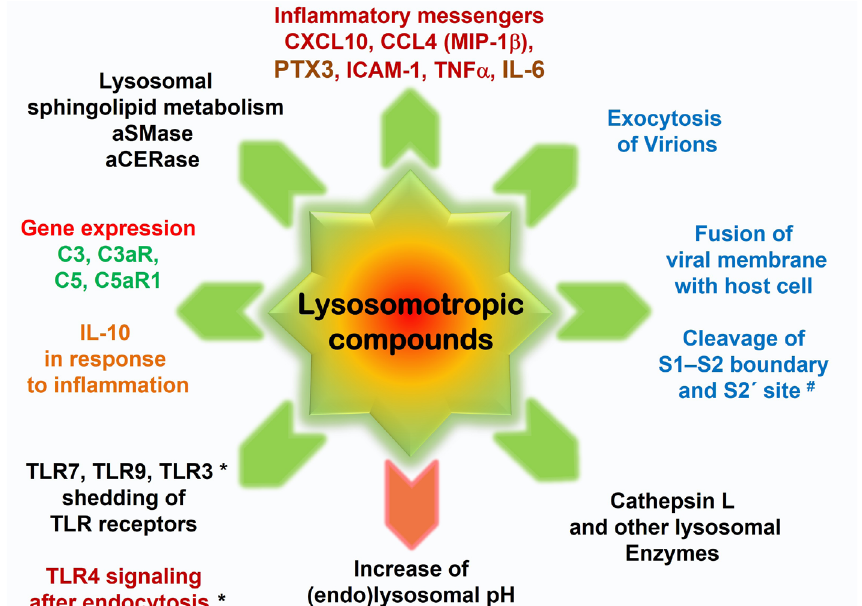
Figure 1. Targets of lysosomotropic drugs and metabolites in sepsis, SARS-CoV-2 infection, and severe SARS-CoV-2 infection/ COVID-19. Lysosomotropic compounds aim various targets in host cells: lysosomal pH, enzymes, and metabolism (black); in response to LPS-induced inflammation/severe viral infection (dark red); in SARS-CoV-2 infection of host cells and viral replication (blue); and the expression of C3, C3aR, C5, and in particular of C5aR1, a highly probable promoter of sepsis and COVID-19 related vasculitides (green) [11, 112 ]. Effects are indicated as decreased (green arrow) and increased (red arrow). * TLR3 shedding and decreasing effects on TLR4 signaling after endocytosis are yet not confirmed, however, highly probable. MIP-1β: macrophage inflammatory